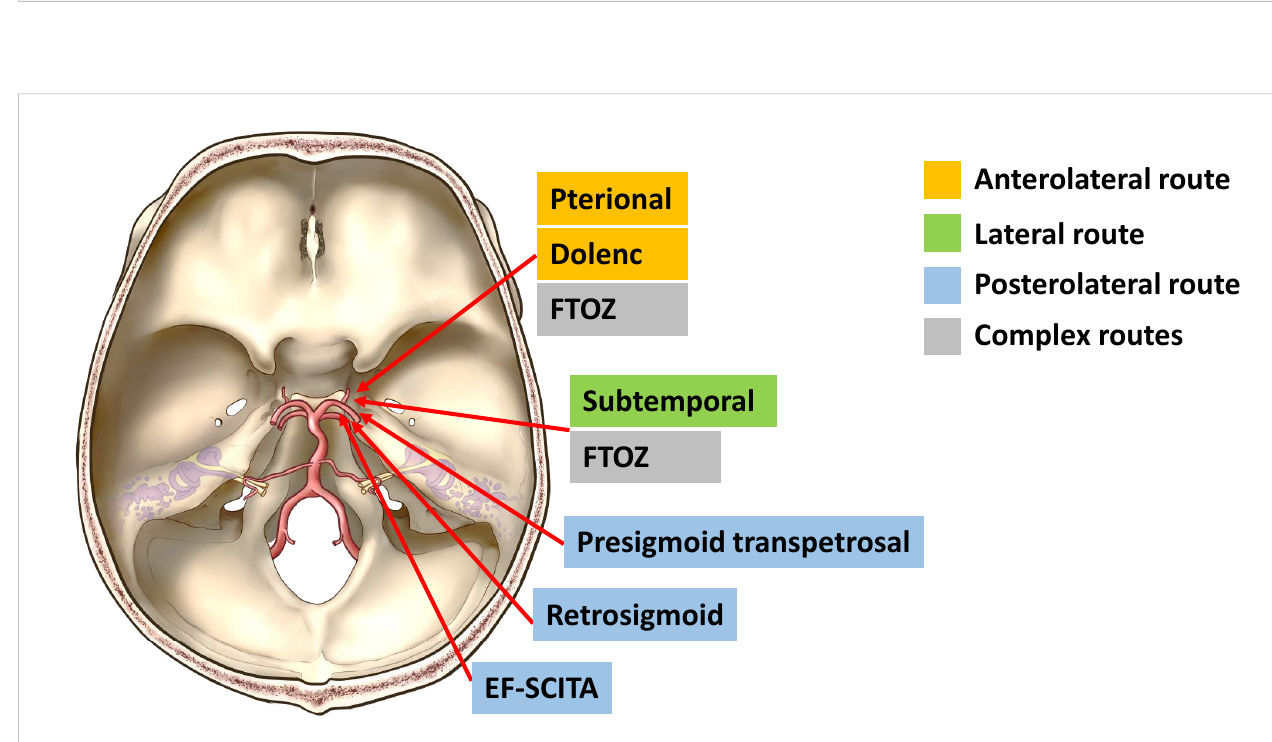
FIGURE 4 Schematic diagram of surgical approaches for resection of posterior clinoid meningiomas. Current approaches for resection of posterior clinoid meningiomas include anterolateral approaches (the classical pterional approach and the Dolenc approach), the lateral approach (the subtemporal approach), posterolateral approaches (the presigmoid transpetrosal approach, the retrosigmoid approach, and the EF-SCITA approach), and the complex route (the FTOZ approach). FTOZ: frontotemporo-orbito-zygomatic orbitozygomatic approach; EF-SCITA: endoscopic far-lateral supracerebellar infratentorial